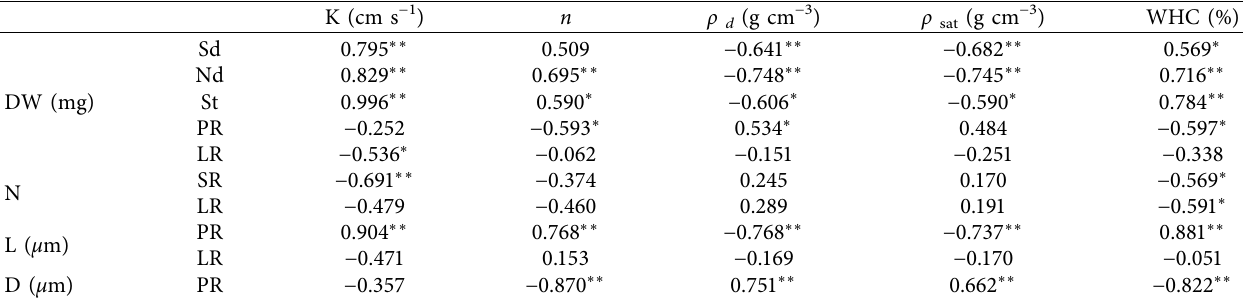
Table 6: Pearson correlation coefficients between soil hydromechanical characteristics and seedling growth and root architecture at 5% risk of the